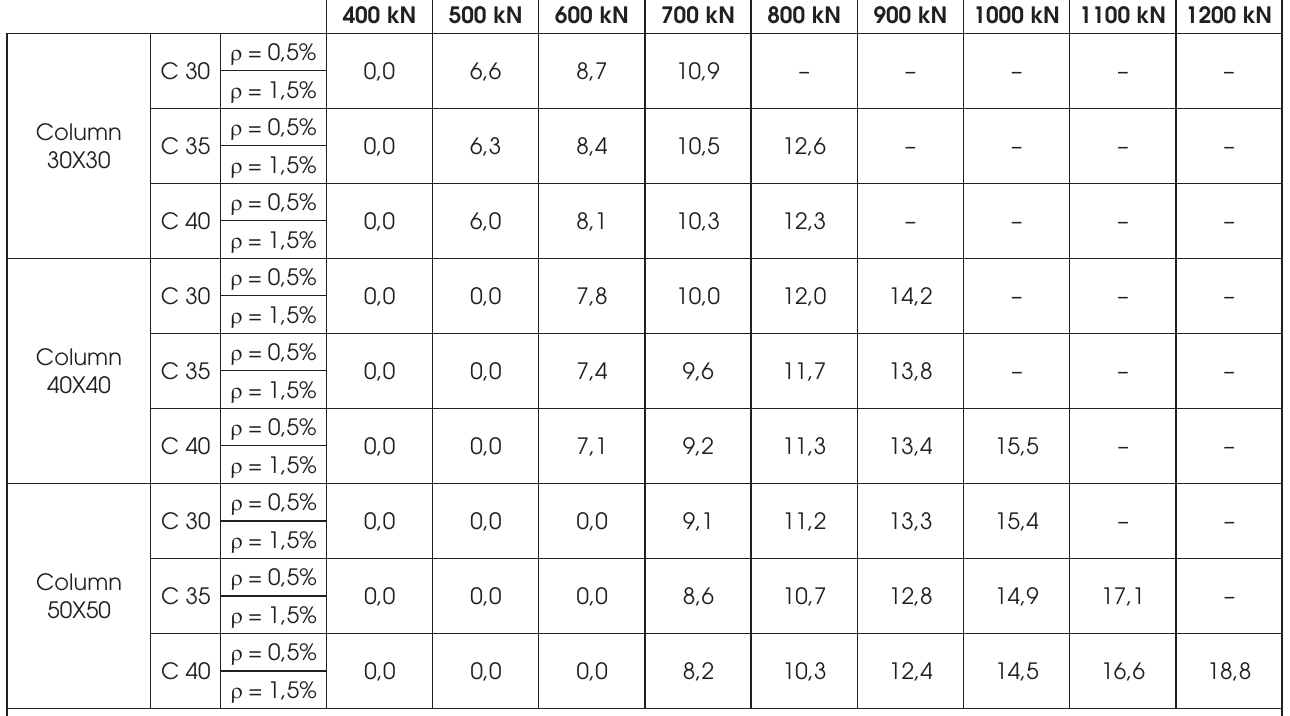
Area of shear reinforcement (cm²) by ACI 318-11 (analysis 1)